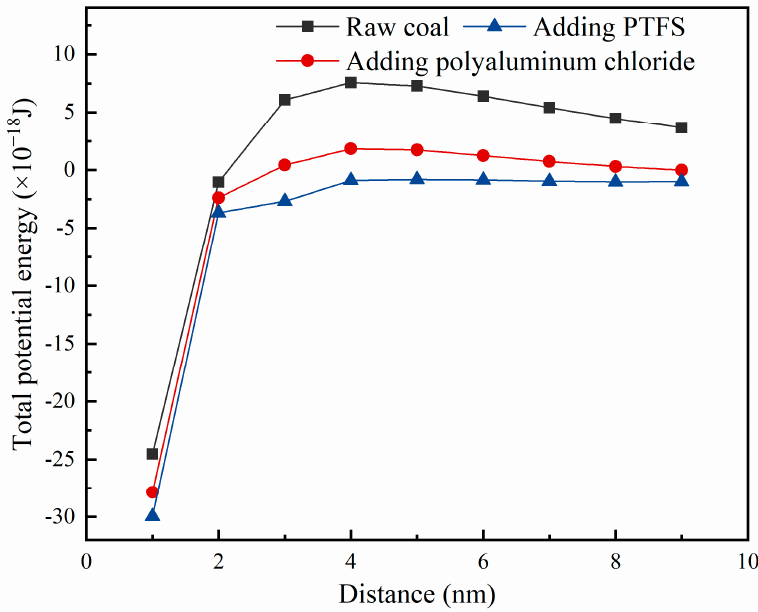
Figure 5. Diagram of distance and total potential